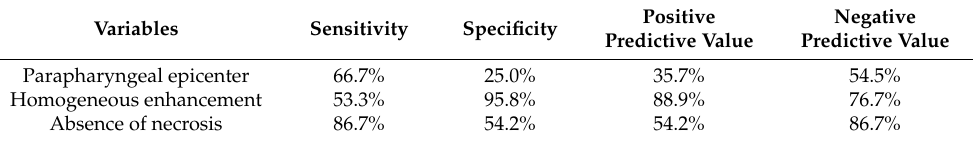
Table 3. Diagnostic performances of variables for differentiating GPA from